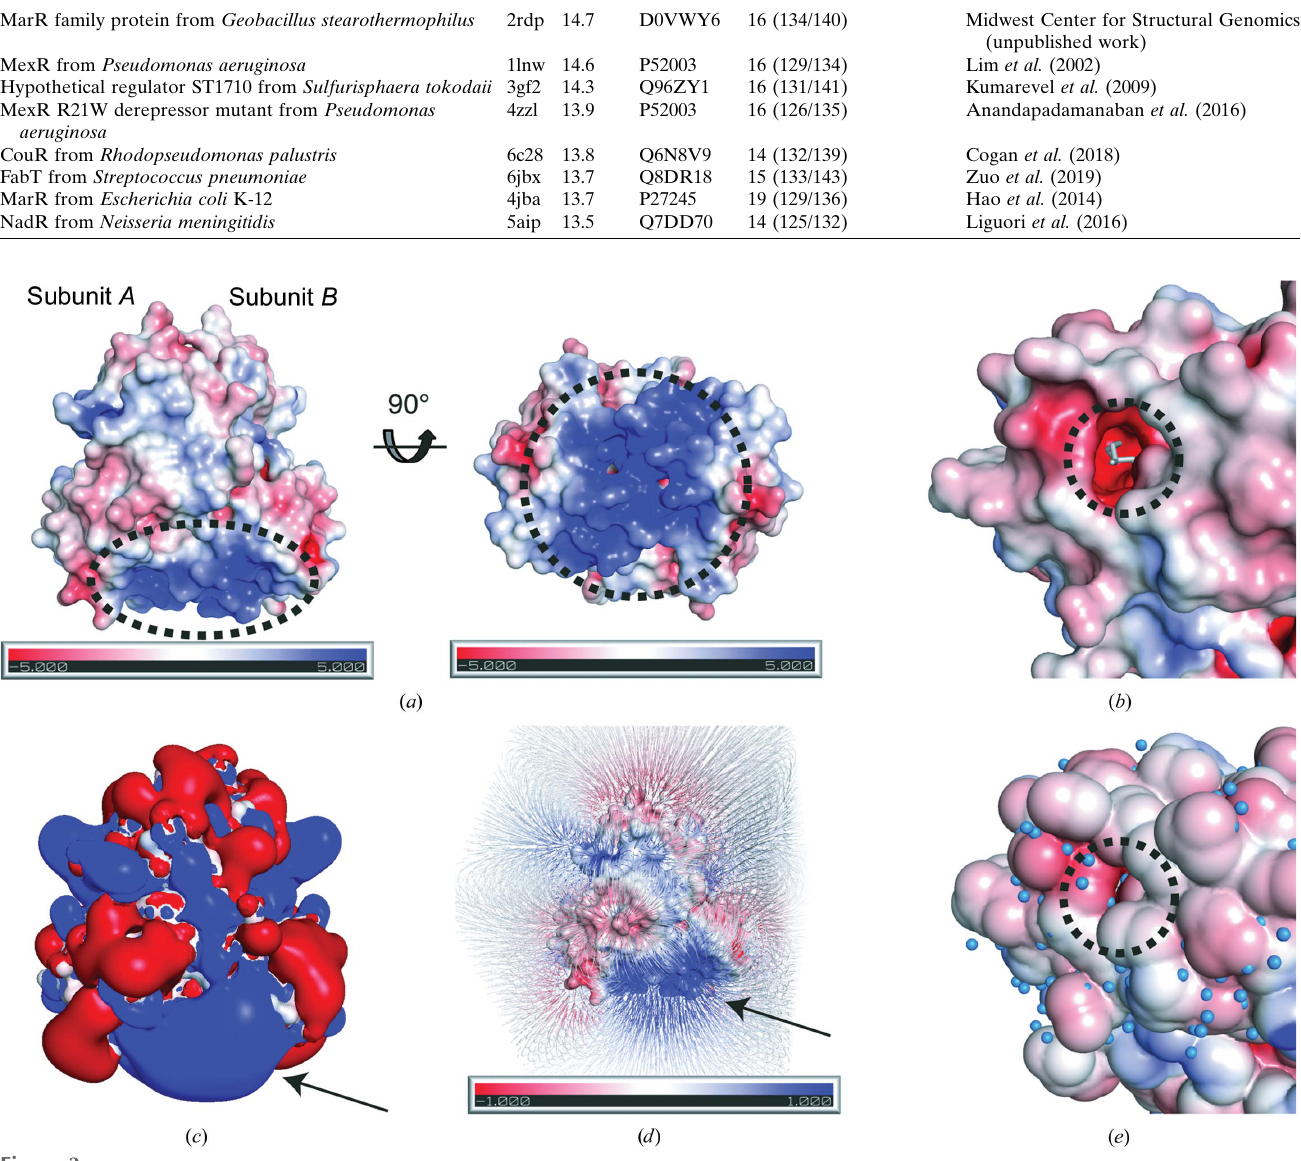
Figure 3 Surface electrostatic potential of Pa MarR. ( a ) Overall electrostatic potential. Surface electrostatic distribution is viewed in two different orientations. The scale ranges from (cid:3) 5 kT e (cid:3) 1 (red) to 5 kT e (cid:3) 1 (blue). The black dashed ellipse indicates the DNA-binding site of Pa MarR. ( b ) Surface electrostatic potential at the entrance to the effector-binding site. Palmitic acid is represented as sticks. The black dashed circle denotes the entrance. ( c ) Electrostatic potential isocontour shown as red ( (cid:3) 1 kT e (cid:3) 1 ) and blue (+1 kT e (cid:3) 1 ) surfaces. The arrow indicates the DNA-binding site. ( d ) Electric field generated by the surface electrostatic potential of Pa MarR. The surface electrostatic potential distribution is the same as in ( a ). The arrow indicates the DNA-binding site. The electric field map is contoured and described at the (cid:3) 0.5 (cid:5) level. ( e ) Solvent-accessible surface area. The black dashed circle indicates the entrance to the effector-binding site. Blue spheres indicate water